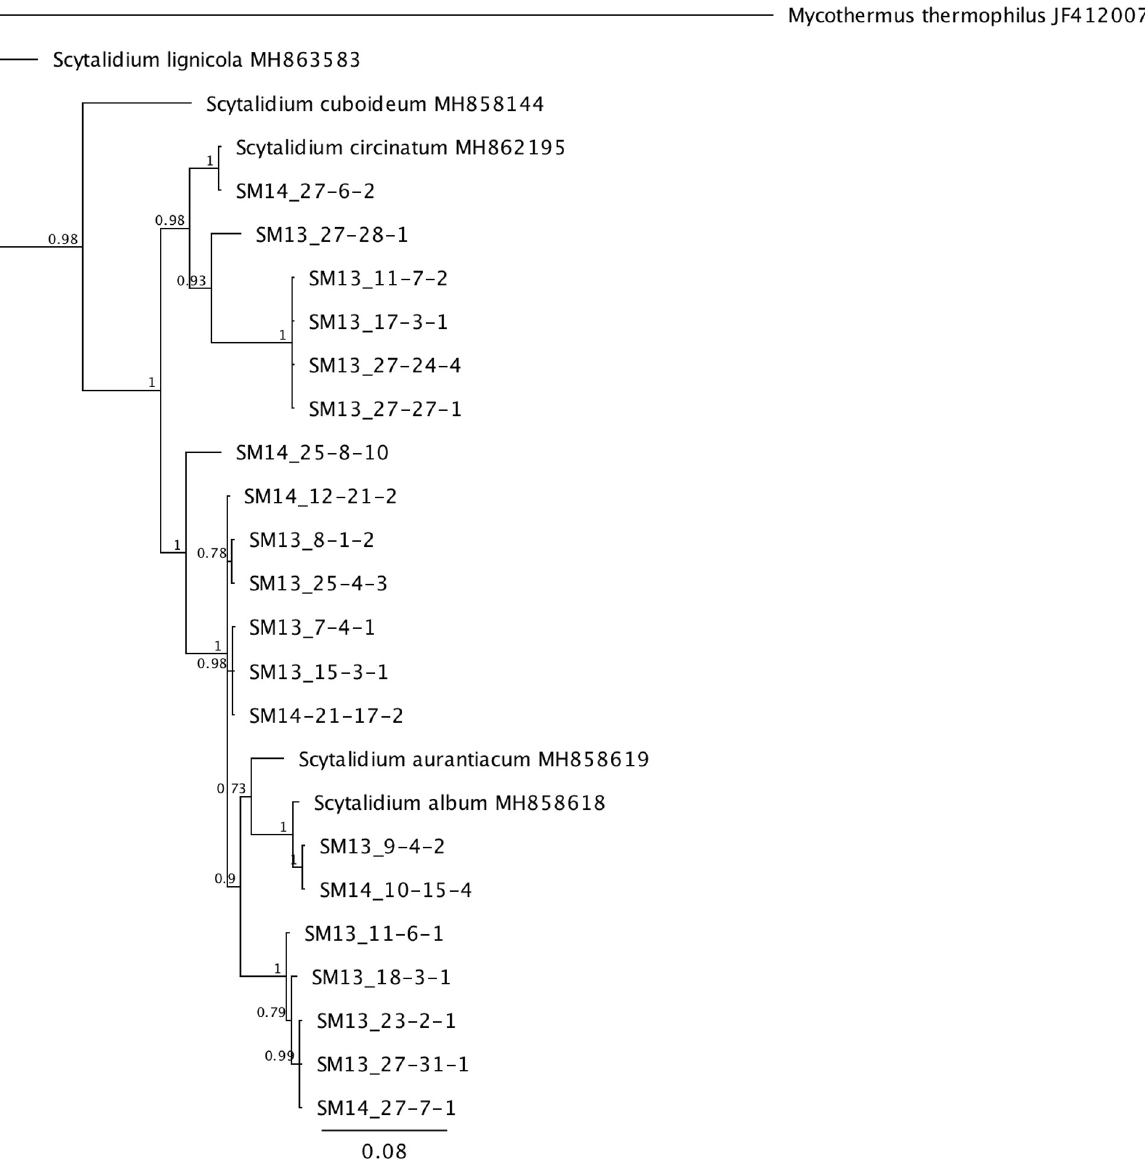
Fig 2. Bayesian tree constructed using ITS sequences from Scytalidium species isolated from the Soudan mine (preceded with “SM”) and related genera. Posterior probabilities are shown at branches.